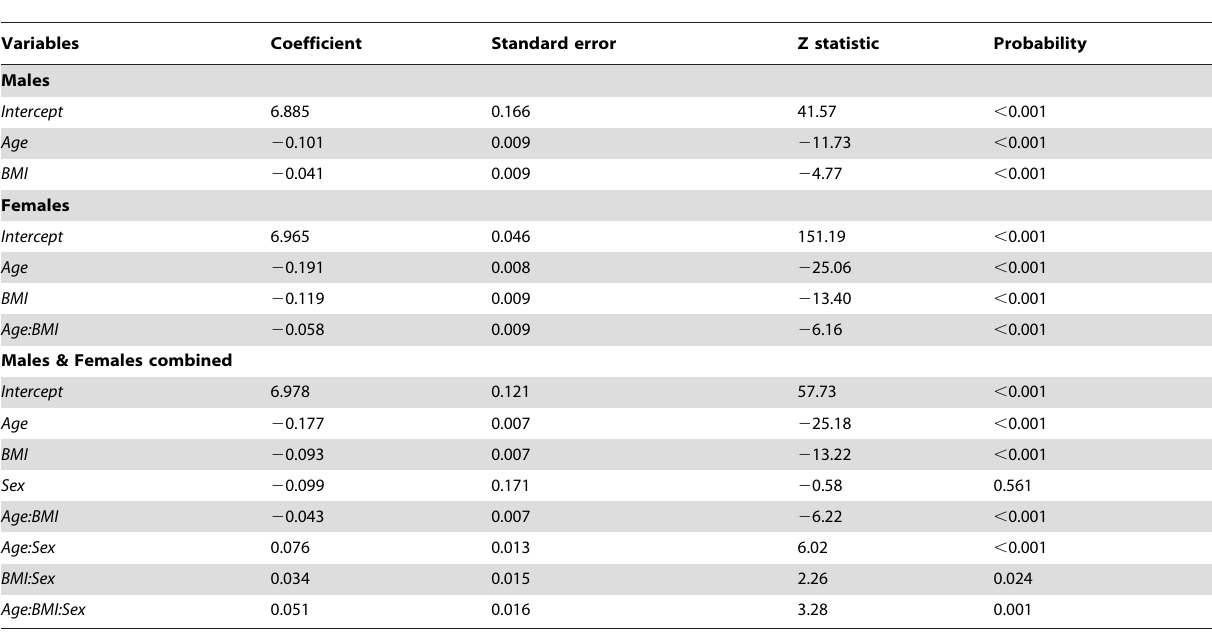
Table 1. Coefficients showing the influence of age, BMI and sex on